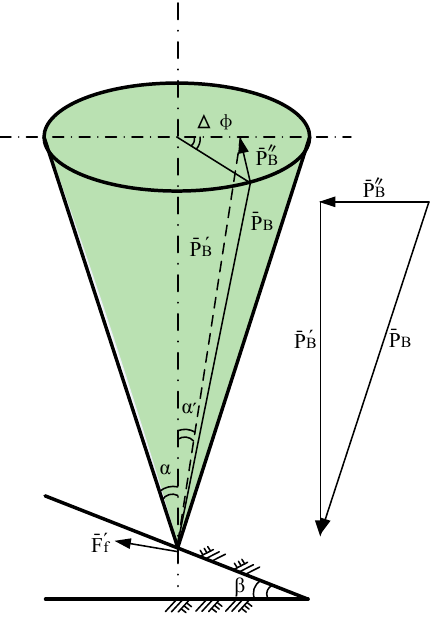
Figure 15. Breakdown of drilling pressure cone and drilling pressure.